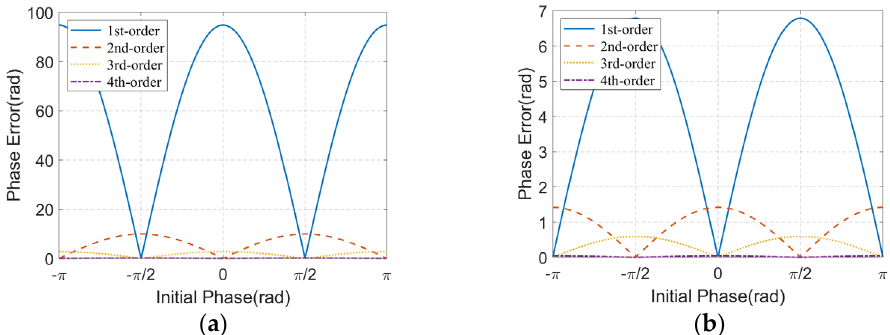
Figure 10. The maximum variation of phase error components from 1st-order to 4th-order, the oscillation period and amplitude is set as 30 s and 1 m, respectively. ( a ) Target oscillates along the range direction; ( b ) target oscillates along the azimuth direction.